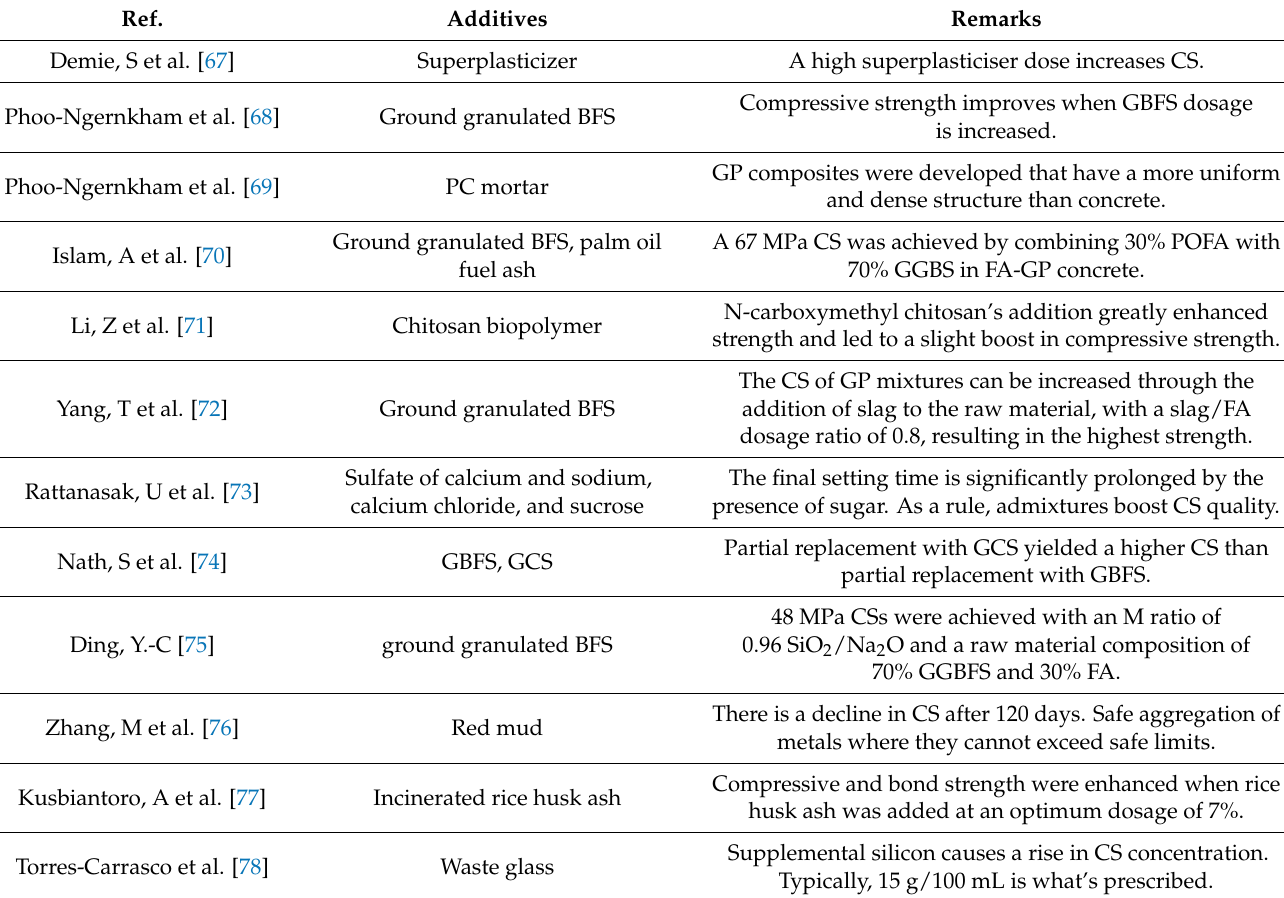
Table 3. Effect of different additives on geopolymer concrete compressive